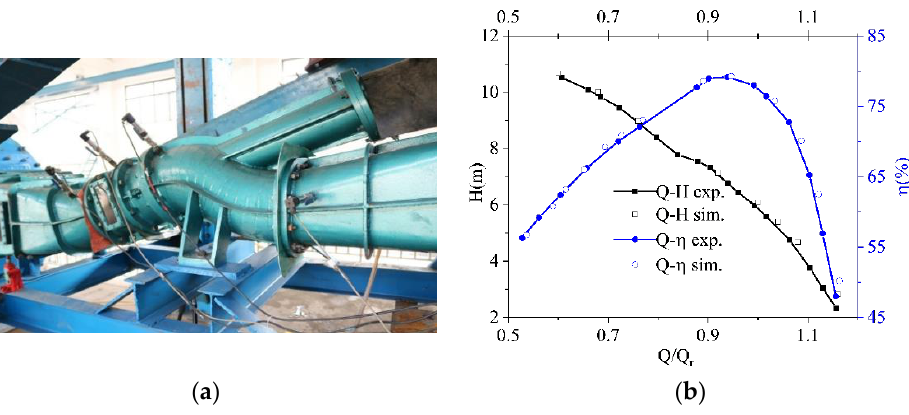
Figure 3. Test rig and variation of head and efficiency under steady-state conditions. ( a ) Test rig of the model pump. ( b ) Comparison of head and efficiency between the test and the simulation.